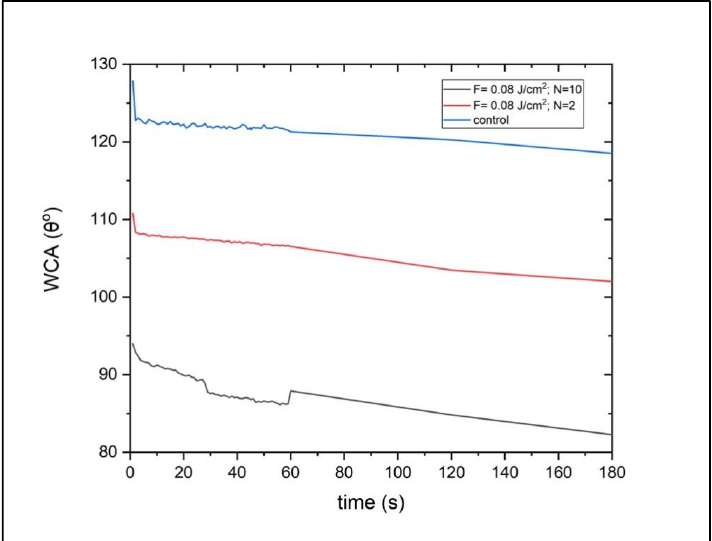
Figure 4. Water contact angle evaluation before and after fs-laser treatment. The scaffolds processed with F = 0.08 J/cm 2 and N = 10 showed an improved wettability behaviour ( θ = 94° at t = 1 s; θ = 82.3°